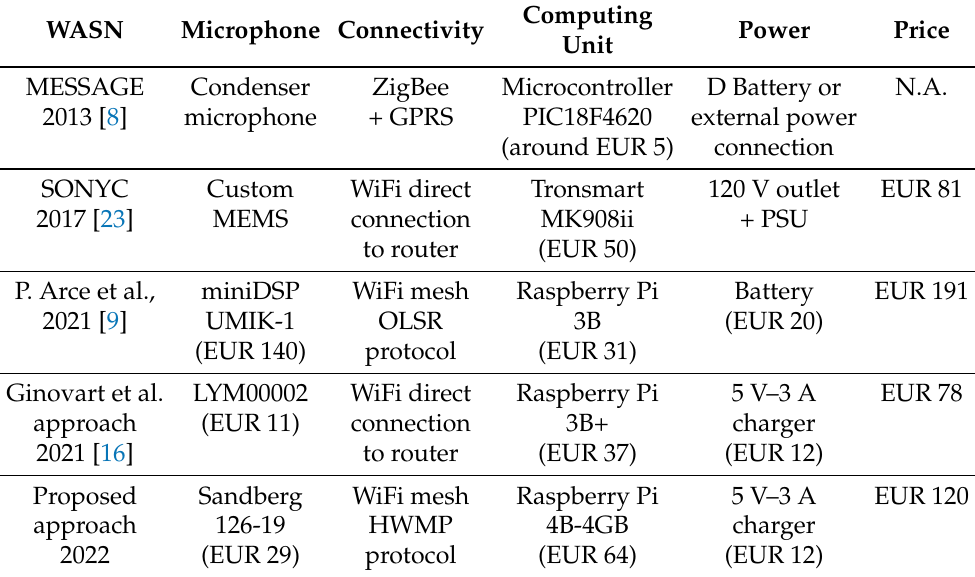
Table 5. Comparative table of different WASNs. The last row represents the approach proposed in this paper. The last column indicates the price per node of each node of the network. Unavailable (N.A.) or missing prices have not been included in the table.